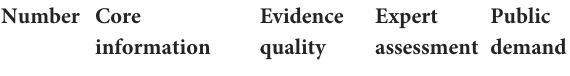
TABLE 7 The correlation between smoking and risks of female mental